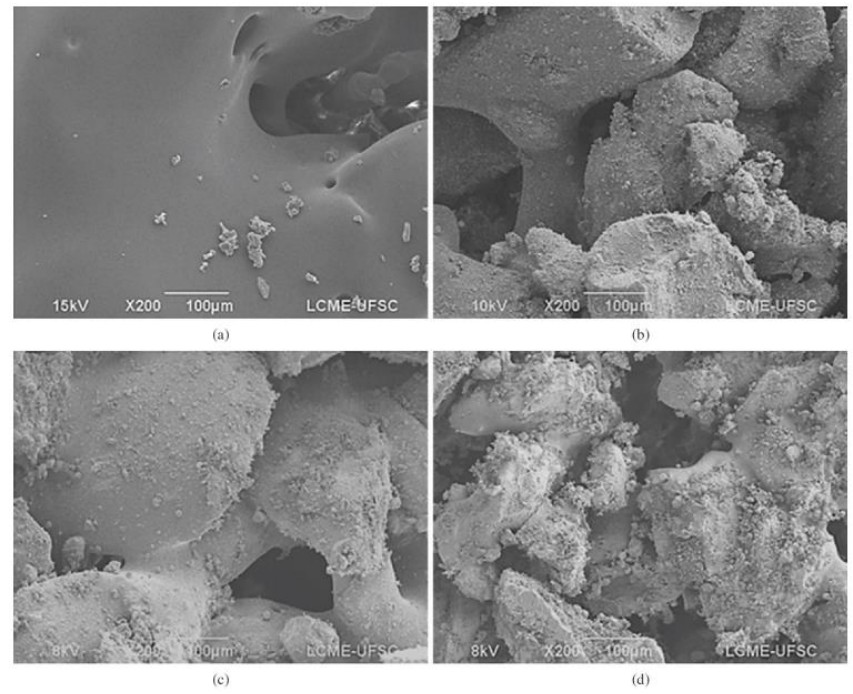
Figure 13. Micrographs with 200× of magnification. ( a ) pure polymer; ( b ) polymer with 10 wt% of BG; ( c ) polymer with 20%wt of BG; ( d ) polymer with 30 wt% of BG. Reproduced from [167]. Karl et al. [170] fabricated a PLGA/BG composite microsphere for SLS. This powder was produced by a solid-in-oil-in-water (s/o/w) emulsion method. They studied the influ- ence of the process to produce porous microparticles, the influence of BG content on the macro/microstructure and the SLS application to fabricate structures with these micro- spheres. These kind of microporous particles could have others biomedical applications such as carriers for drugs, absorption of substances, pulmonary drug delivery and tissue regeneration [5,171]. Xu et al. [172] studied the effect of polydopamine as a cross-linking bridge between mesoporous BG and PLLA to improve the interfacial interaction during the scaffold fabri- cation. Afterwards, Xu et al. [173] studied the mechanical and biological properties of a scaffold based on a blend of PLA and PGA (PGPL) filled with polydopamine functional- ized mesoporous BG with dexamethasone (DEX). The mBG had promoted cell prolifera- tion and DEX increased the alkaline phosphate (ALP) activity of osteoblasts and thus bone formation and calcification. Qian et al. [174] introduced Ag ions into mesoporous BG nanoparticles since it pre- sents an antibacterial capacity. The mechanical tests as well as the in-vitro test confirmed the good mechanical properties, admirable antibacterial ability and cytocompatibility. Some studies, proposed a debinding and sintering step to eliminate the organic phase and obtain BG scaffolds with high porosity. In this case, the authors used binders like stearic acid (SA) as a supporting material: during the SLS process the laser melts the stea- ric acid which bonds the BG particles. Afterwards, the scaffolds are post-processed at 550° C to burn out the binder and to sinter the 13 – 93 glass particles. This thermal treatment did not affect the amorphous nature of the BG, which could otherwise have an impact on the bioactivity [31,66]. The works of Kolan et al. [175 – 177] studied the morphological, me- chanical and bioactive properties of BG13-93 scaffolds elaborated by SLS technique. They